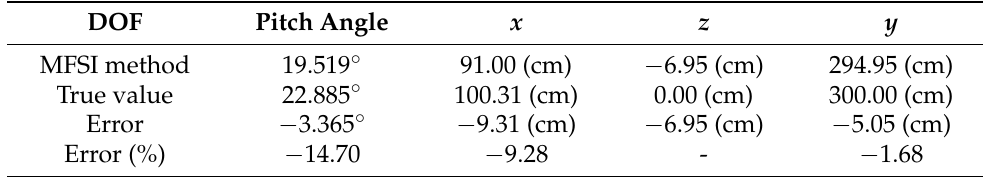
Figure 11. The radiated magnetic field in experiments. TrackingReceiver 1 and TrackingReceiver 2 are the measured magnetic field on the point (0.91, 3, 0) and point (0.91, 3.829, 0.35) in meters, respectively. The pitch angle of the dual receivers α is 22.885 ◦ . TrackingReceiver 1 compensation is the compensated magnetic field by the MFSI method. Table 5. The tracking error of the algorithm in the pitch angle